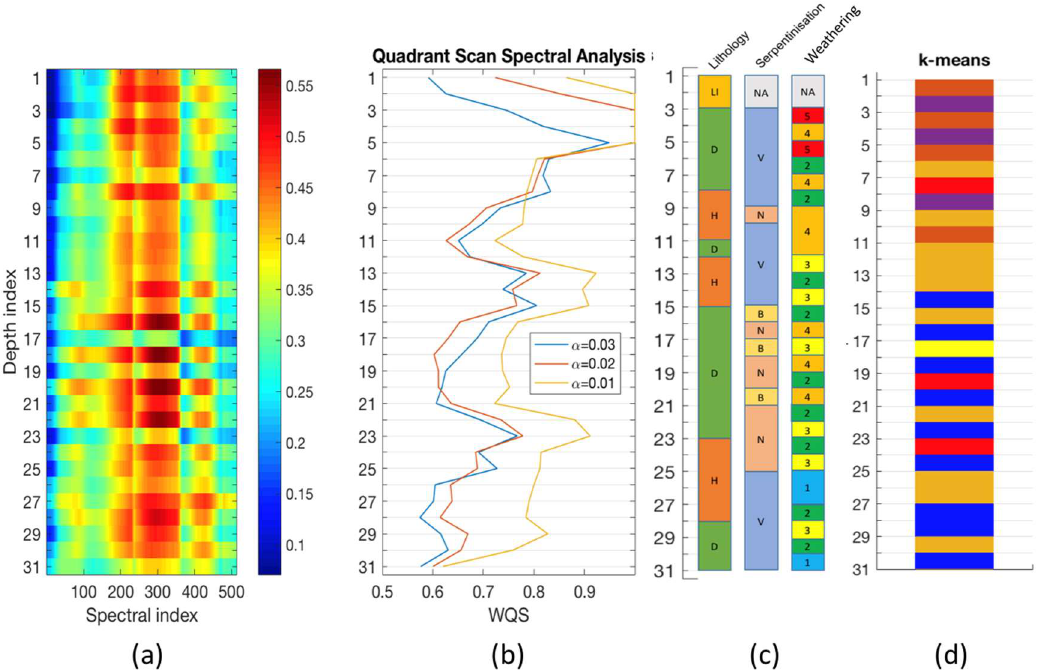
Figure 8. BOULINDA drill-hole. ( a ) Heatmap plot of depth index against spectral index (blue colours reflect low values and red colours reflect high values); ( b ) Weighted quadrant scan results from the spectral data using three different values of α , peaks indicate lithological boundaries; ( c ) The boundaries identified manually by domain experts (see Table 1 for geology logging codes), and; ( d ) results of k-means clustering with k = 8 (the different colours represent different clusters). The depth sampling intervals are irregular; therefore, the figures in this manuscript show the results in terms of depth indices. The corresponding actual depths are shown for each hole in Table